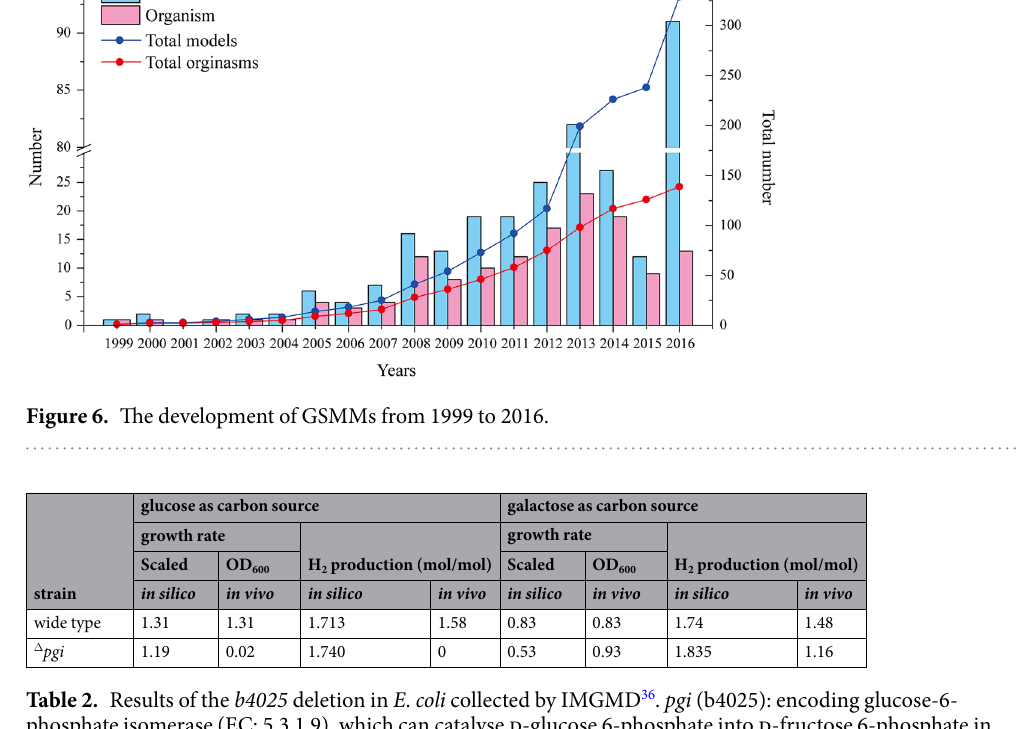
H 2 production (mol/mol)Scaled OD 600 Scaled OD 600